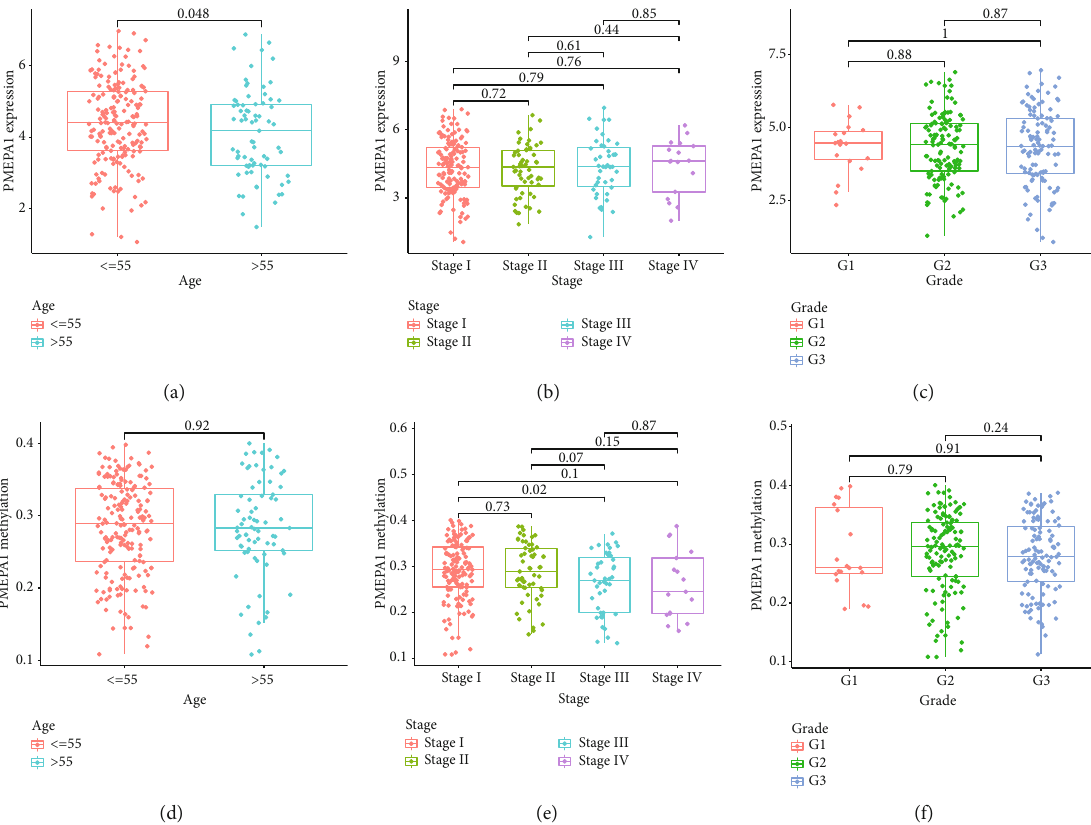
Figure 5: The association between PMEPA1 expression/methylation and clinicopathologic characteristics in CC, patients. (a) – (c) The association between PMEPA1 expressing and (a) age, (b) stage, and (c) grade in CC patients. (d) – (F) The association between PMEPA1 methylation and (d) age, (e) stage, and (f) grade in CC patients.